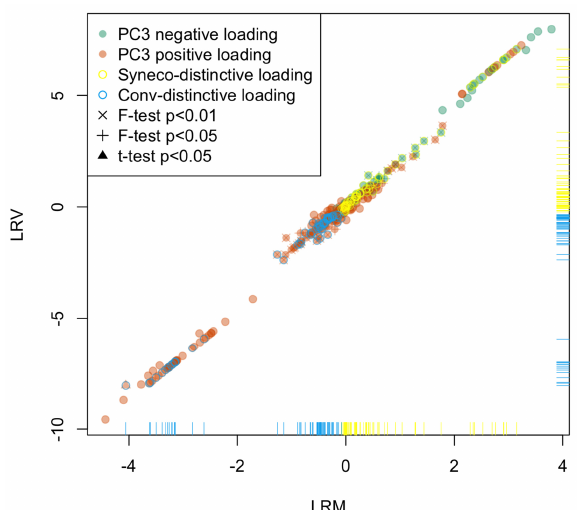
Figure 1. Results of metabolome analysis of coarse green tea samples. The log(Syneco/Conv) values of mean intensity (LRM) and variance (LRV) of 342 peaks obtained by LC-MS are plotted. The horizontal axis represents the LRM, and the vertical axis represents the LRV (see Methods). So if these values are positive, it means that the Syneco sample is larger than the Conv sample in the mean intensity or the variance. The green circles represent PC3 negative loadings in PCA (as shown in Figure 3), and the orange circles represent PC3 positive loadings. As an exception, in the t -test of the intensity of Syneco vs. Conv, a compound with p < 0.05 is represented by a triangle instead of a circle. The yellow and light blue hollow circles represent Syneco-distinctive loadings and Conv-distinctive loadings, respectively, which are the top 130 loadings that can completely separate the two culture conditions with PCA (see Figure 3). The saltires represent the compounds with p < 0.01 in the F-test of Syneco vs. Conv, and the crosses represent the compounds with p < 0.05.